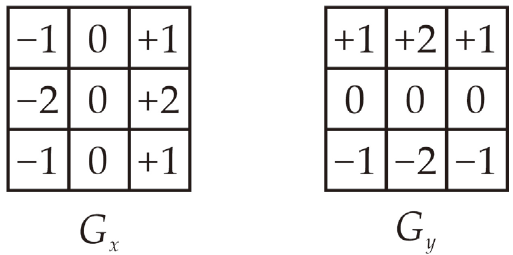
Figure 3. Sobel convolution factor.